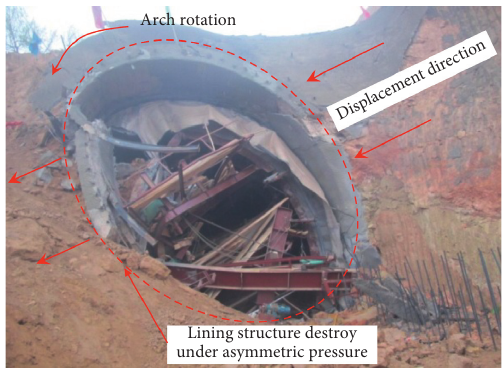
Figure 1: Tunnel collapsed under